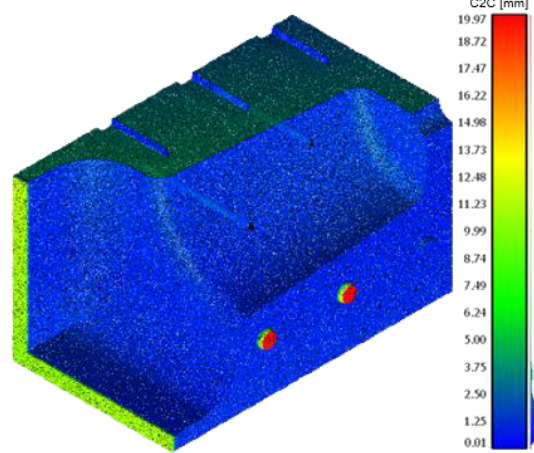
Figure 5 . C2C deviation of the Original model as point cloud to the point cloud of modified object after